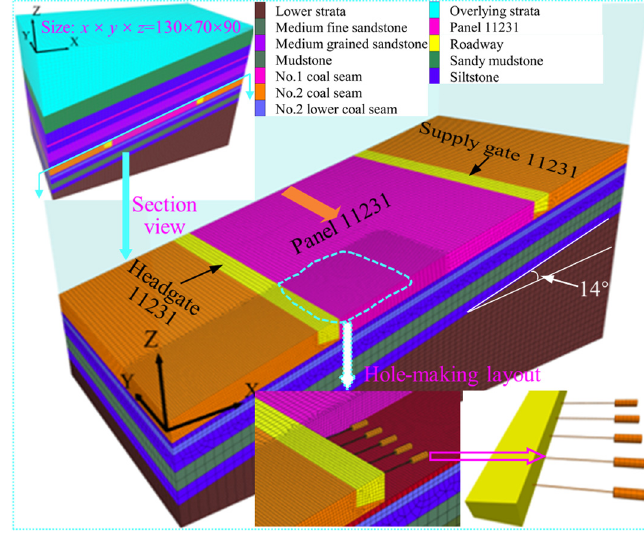
Figure 8. Numerical simulation model. Table 1. Mechanical parameters of coal and rock strata.